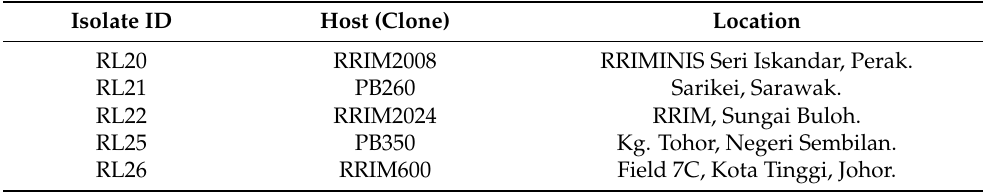
Table 1. Source of white root rot